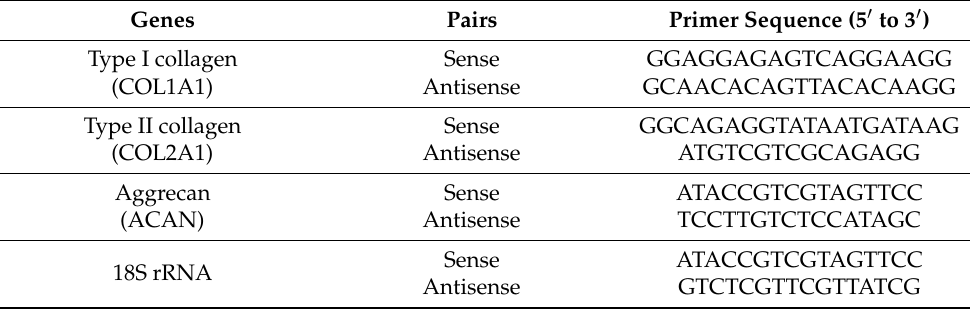
Table 2. Sequences of each primer set for qRT-PCR.